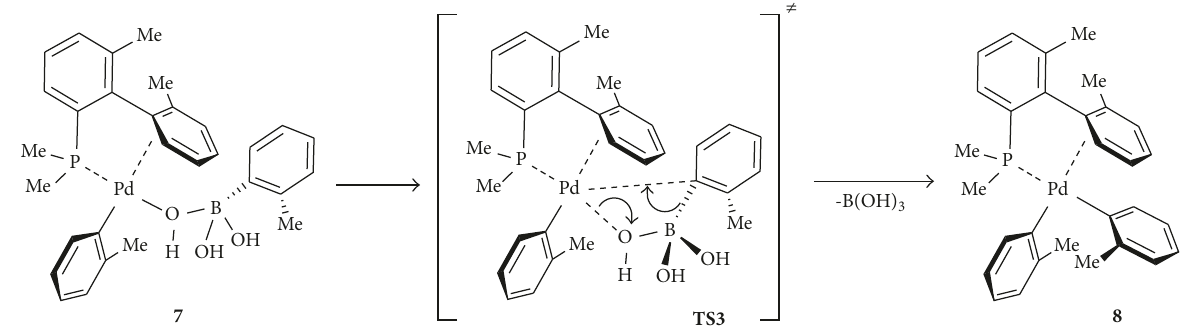
Scheme 6: Formation of the transition stage TS3